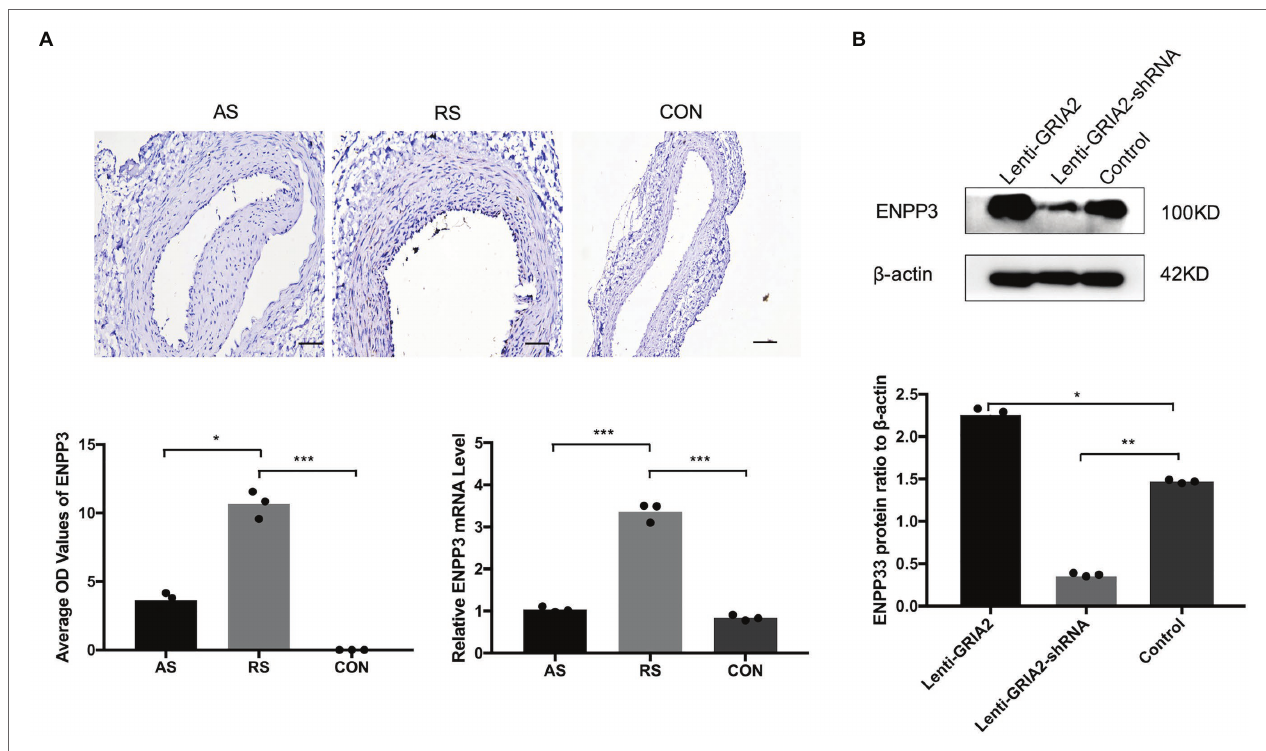
FIGURE 4 | GRIA2 interacted with ENPP3 in restenosis. (A) Immunohistochemical analysis and quantitative mRNA analysis showed the expression of ENPP3 in restenotic plaque tissues, atherosclerotic plaque tissues and healthy control artery tissues ( n = 3). Optical density (OD) values are the statistical calculations in the intima. Images are representative, and the bar graph shows the average data of three independent experiments ( n = 3). Staining was performed at 200 × magnification (scale bar, 50 μ m). (B) The expression of ENPP3 in VSMCs after upregulating GRIA2 expression. Blots are representative, and the bar graph shows the average data ( n = 3). *Statistically significant difference ( p < 0.05), **statistically significant difference (p < 0.01), and ***statistically significant difference ( p < 0.001). AS: atherosclerotic; RS: restenotic; CON: control; VSMCs: vascular smooth muscle